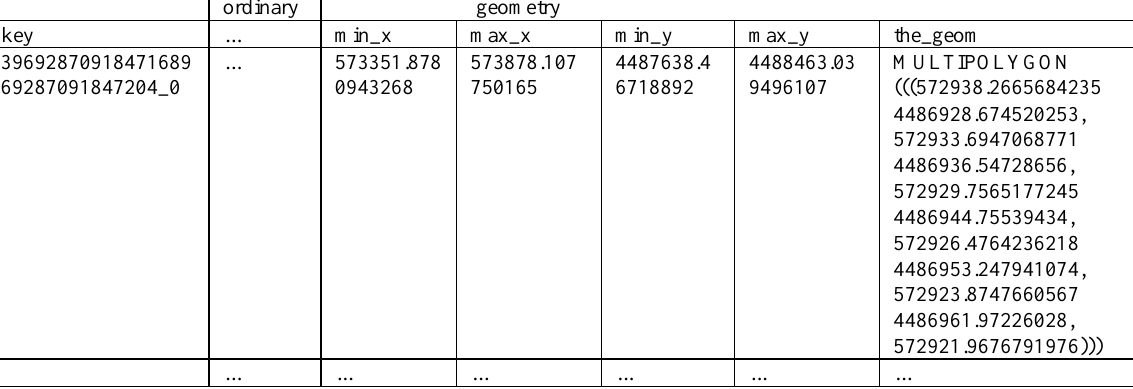
Table 4 . Design of Detail Table in HBase.